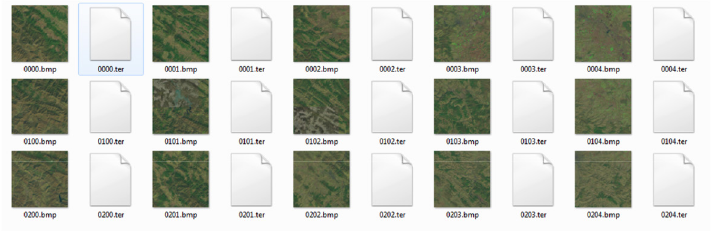
Fig. 11. Terragen folder in the Condor program with exported bitmap files (each file is a single